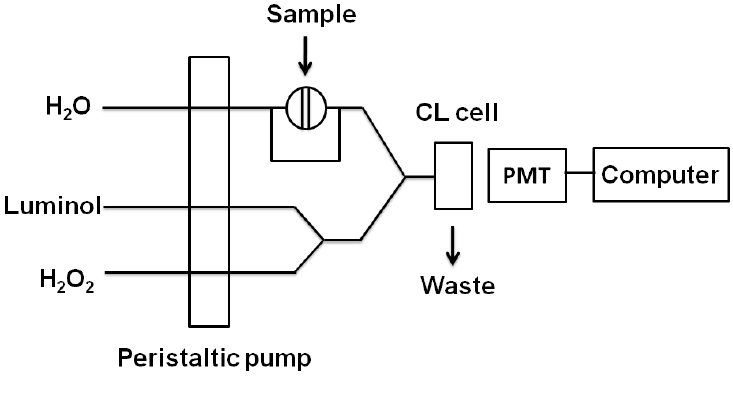
Figure 1. Schematic diagram of flow injection CL